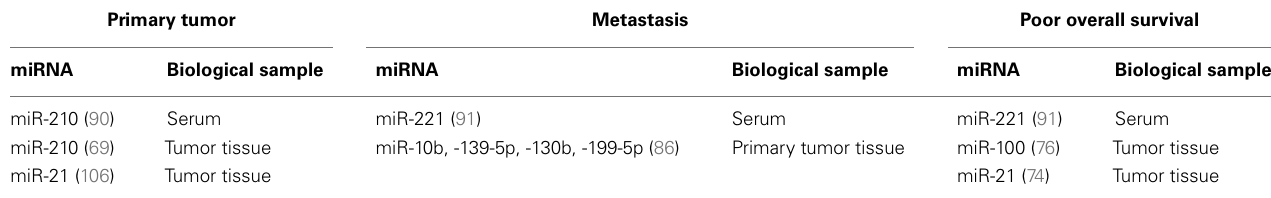
Table 2 | Prognostic biomarkers for